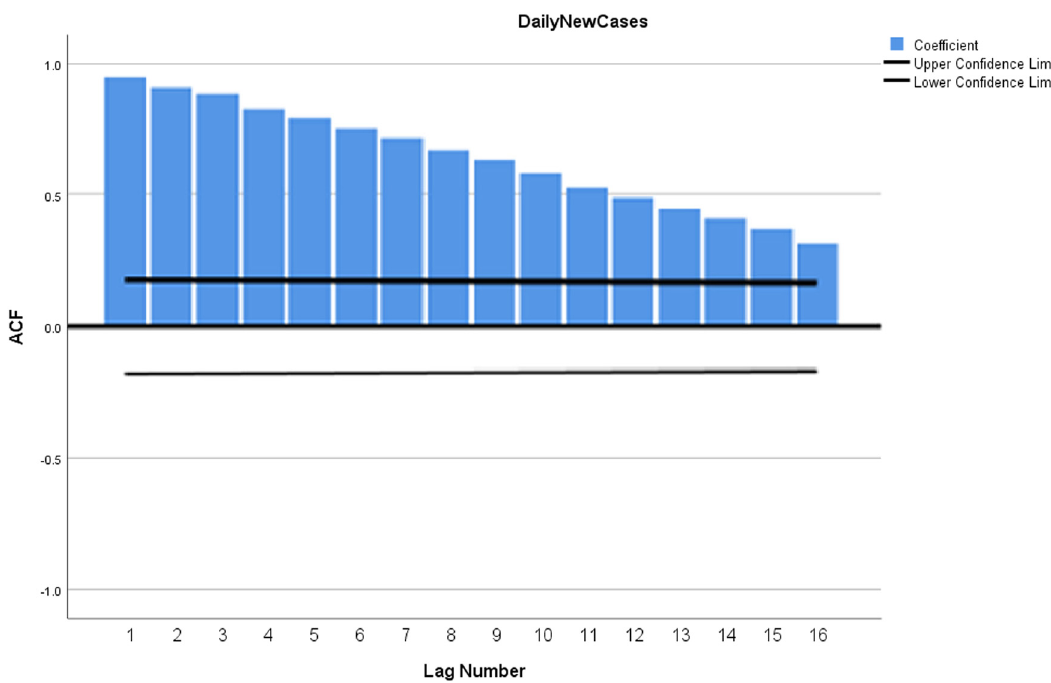
Figure 2: ACF of the original